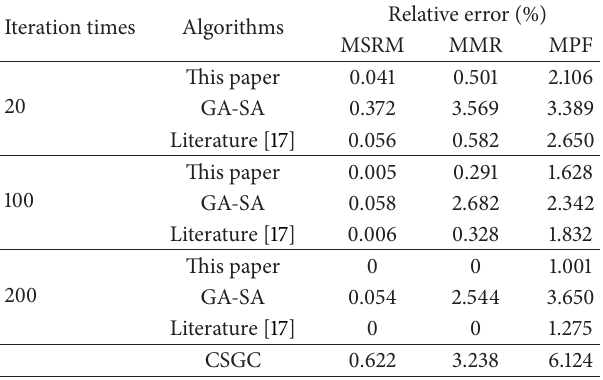
Table 3: Relative error of different algorithms under different iteration times ( 𝑀 = 𝑁 = 5 ).